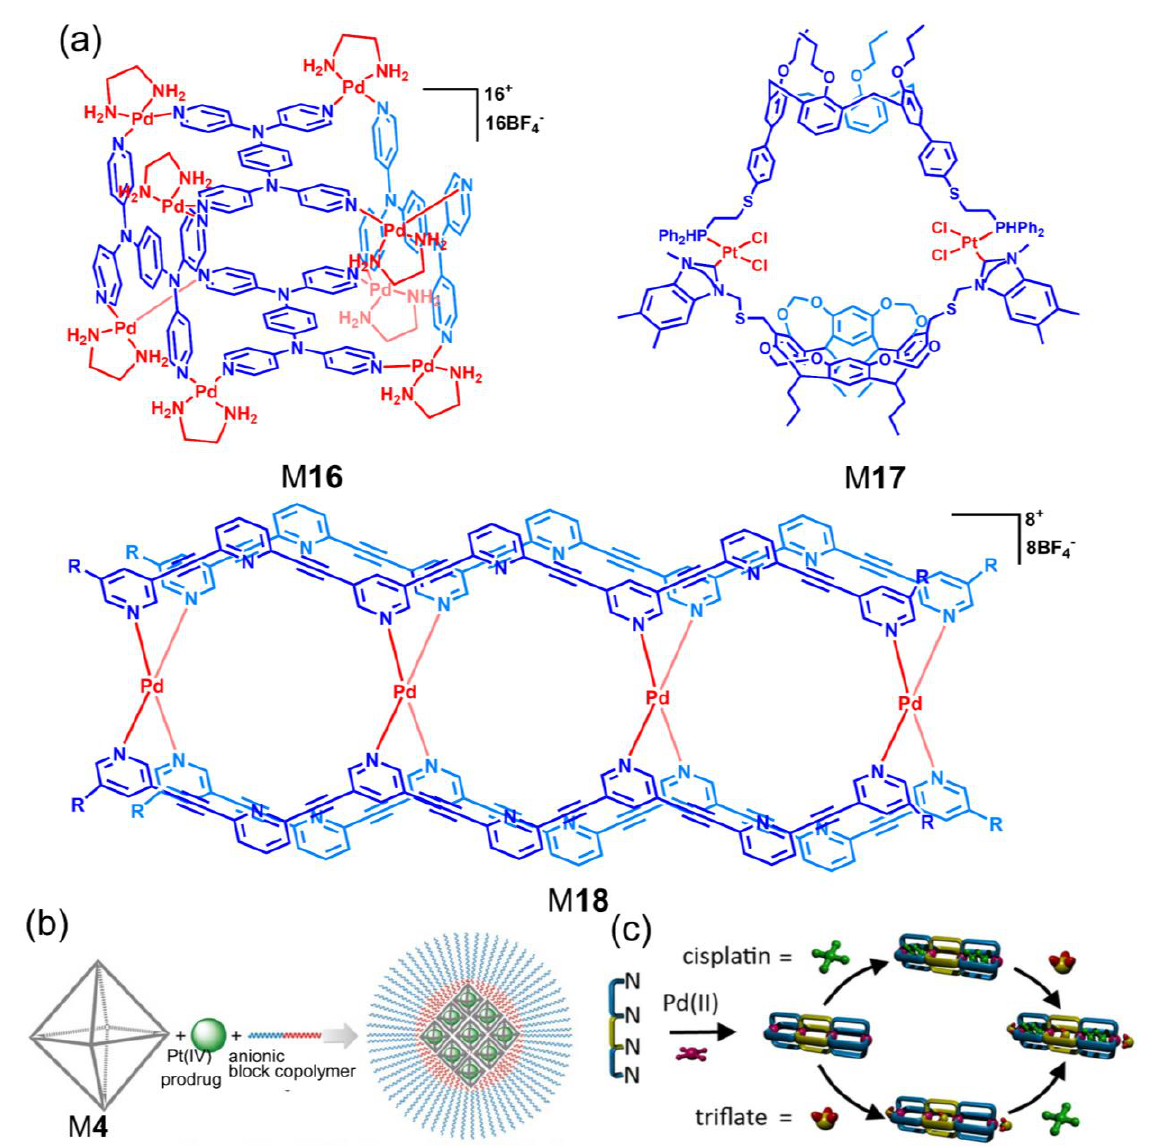
Figure 3. Drug encapsulation and delivery of metallacycles and metallacages. ( a ) The structures of M 16 − M 18 . ( b ) The nanoformulation of M 4 for Pt drug delivery. ( c ) Selective binding of cisplatin and triflation in cavities. Adapted with permission from refs. 66 – 68, 74. Copyright 2017 American Chemical Society; 2018 Royal Society of Chemistry.